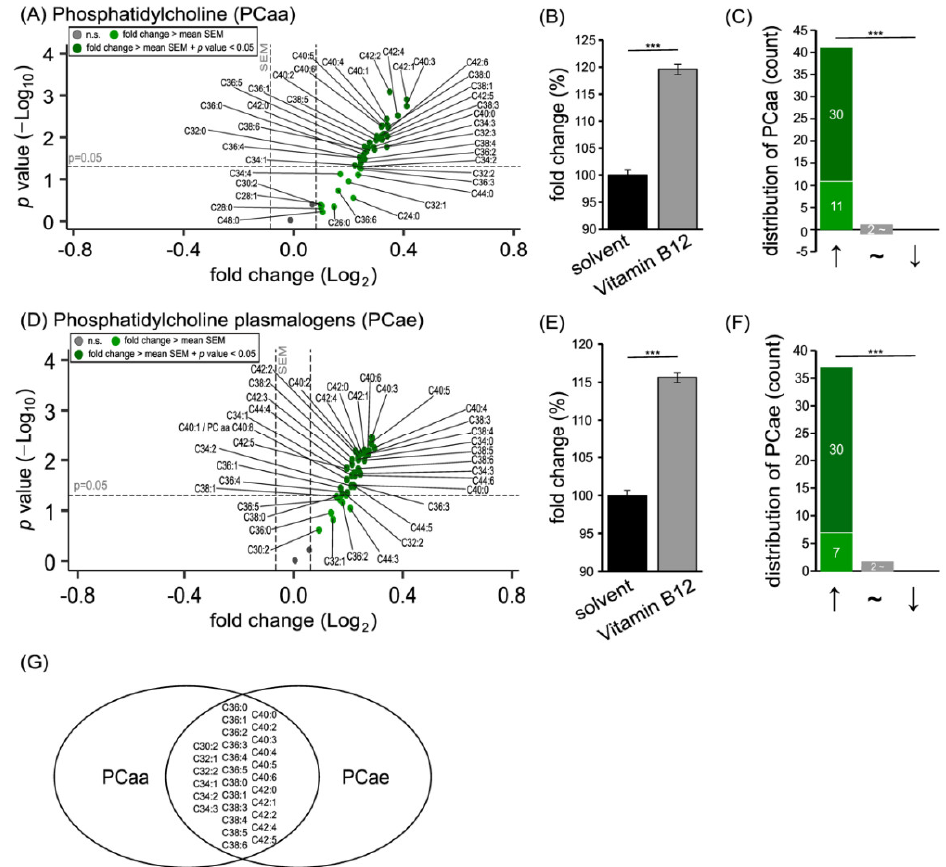
Figure 1. Effect of vitamin B12 treatment on phosphatidylcholine (PCaa) and phosphatidylcholine plasmalogens (PCae) species. SH-SY5Y cells treated with vitamin B12 compared to cells treated with the solvent control (HPLC water). ( A ) In the volcano plot, each PCaa species with its fold change (x-axis) in relation to its p -value (y-axis) is shown as a dot. Grey dots represent no significant changes. Light green dots represent a fold change which is greater than the mean standard error of the mean (SEM). Dark green dots represent a fold change which is greater than the mean SEM and, additionally, has a p -value smaller than 0.05 (which was defined as the statistical significance level). ( B ) The bar chart shows the relative fold change of all measured PCaa species after vitamin B12 treatment, in comparison to treatment with the solvent control. ( C ) Distribution of PCaa species structured according to the amount of increased, unchanged, or decreased PCaa species. Grey dots represent no significant changes. Light green dots represent a fold change which is greater than the mean standard error of the mean (SEM). Dark green dots represent a fold change which is greater than the mean SEM and, additionally, has a p value smaller than 0.05. ( D ) Volcano plot showing the changes in PCae species due to vitamin B12 treatment. The plot is structured as described in ( A ). ( E ) Representation of the relative fold change of all measured PCae species in a bar chart. ( F ) Distribution of PCae species. Distribution structured as described in ( C ). ( G ) A Venn diagram of PCaa and PCae species is shown. All phospholipids, which underwent alterations greater than the average SEM, are displayed in the overlapping part. Statistical significance was set as *** p ≤ 0.001.